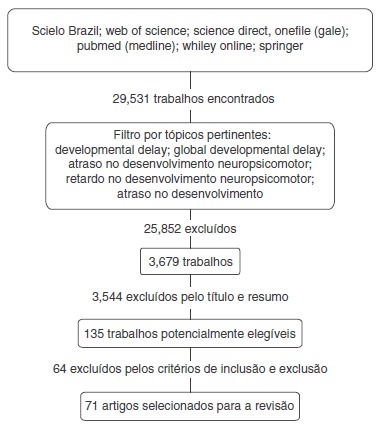
Etapas da busca bibliográfica.